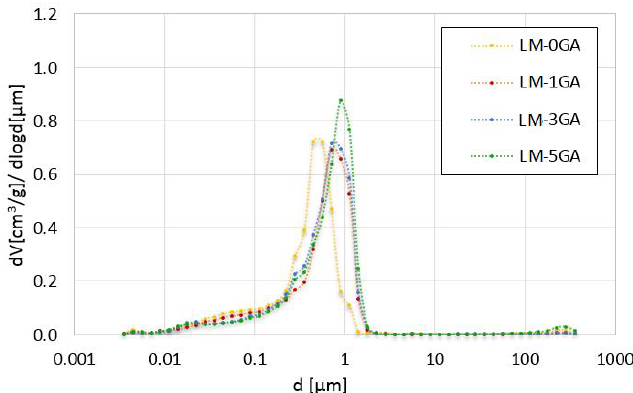
Figure 5. Cumulative volume of intruded mercury versus pore diameter for the tested lime-me- takaolin pastes.